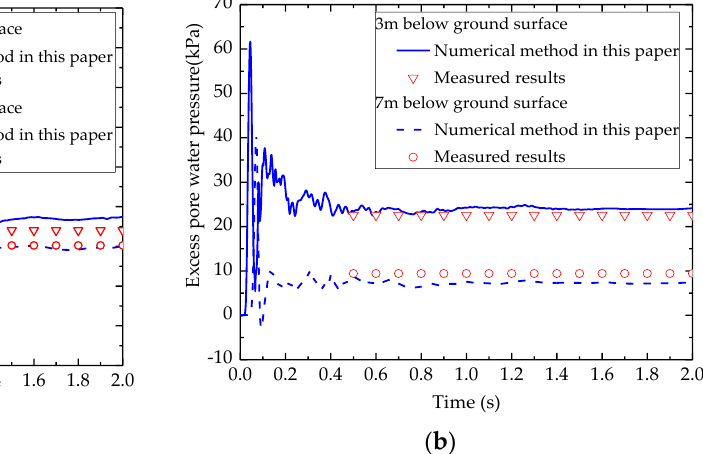
Figure 2. Excess pore water pressure versus time. ( a ) 1500 kN·m; ( b ) 2500 kN·m [17].